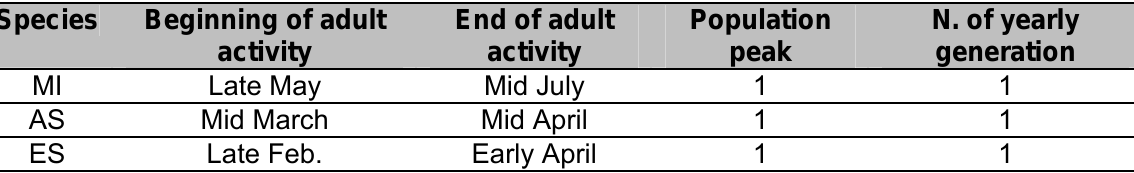
Table 5. Ecological status of predominant blister beetles (Coleoptera: Meloidae) in different localities where meloid dermatitis was reported in